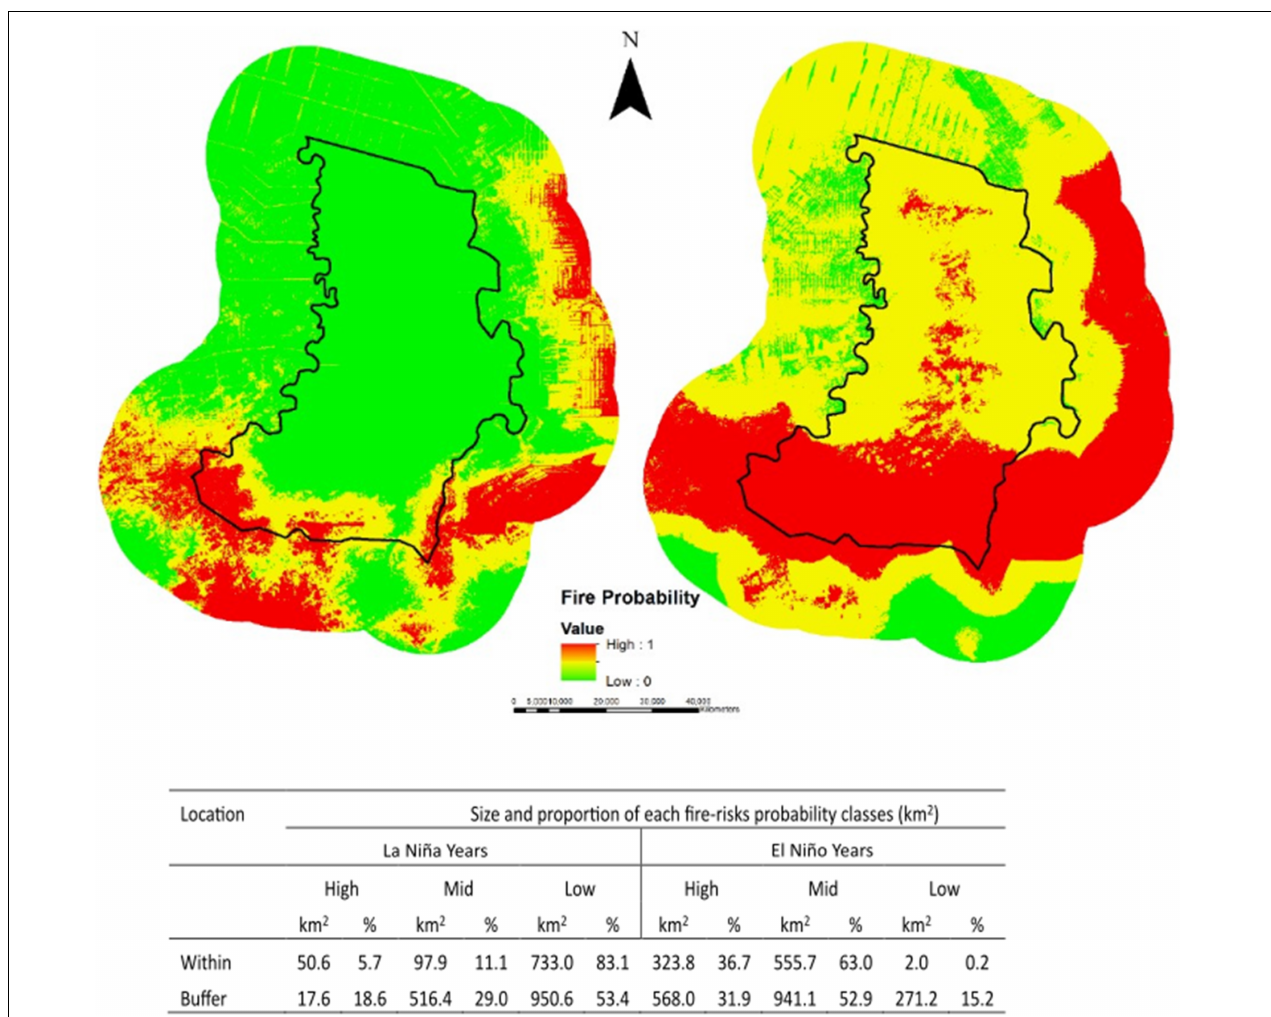
FIGURE 6 | Predicted map of fire-risks probability class for La Niña ( left ) and El Niño ( right ) from the Maximum Entropy Model (Maxent) model. The probability of fire occurrence is represented by different colors ranging from red (high) to green (low). The size and proportion of each classes within the PSWR and it’s buffer area during is shown